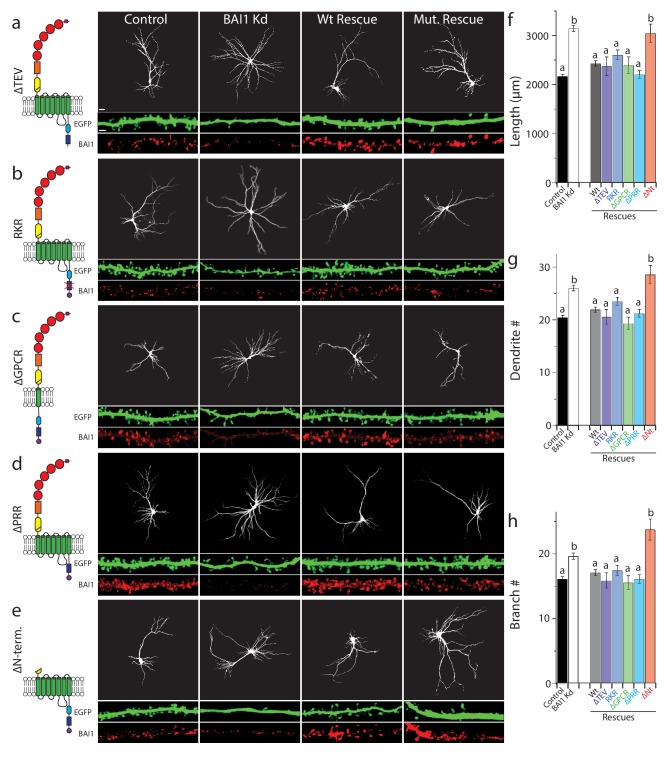
BAI1 requires its extracellular segment to inhibit dendrite growth, but does not employ any known intracellular signaling modality to do so.a through e Representative images of neurons expressing EGFP and control vector (Control), shRNA against Adgrb1 (BAI1 Kd), or shRNAs against BAI1 plus RNAi-resistant BAI1 (Wt rescue) or an RNAi-resistant BAI1 mutant (Mut. rescue). All images are masked to remove axons and dendrites from other neurons. The mutant used for rescue in each series is shown in cartoon form on the left. Mutants used included a deletion of the PDZ-binding core sequence (a), an RKR→AAA mutation in the helical domain that prevents ELMO1 binding (b), deletion of all but the first transmembrane domain of the GPCR domain (c), deletion of the proline-rich region (d), and deletion of the entire N-terminal extracellular segment between the signal sequence and the native autoproteolysis site (e). Representative EGFP images of the entire arbor are on top (bar is 20 µm), while EGFP and BAI1 immunochemistry images reconstructed from 3D confocal stacks of secondary dendrites taken from the same experiments are shown immediately under these (bar is 2.5 µm). (f) Summary data for dendrite length. (g) Summary data for dendrite number. (h) Summary data for branch number. Total number of neurons: 314 for control neurons (N = 24), 288 for BAI1 Kd neurons (N = 24), 235 for wt rescue neurons (N = 24), 29 for ∆TEV rescue neurons (N = 3), 86 for RKR rescue neurons (N = 9), 39 for ∆GPCR neurons (N = 3), 72 for ∆PRR neurons (N = 3), and 37 for (N = 3) for ∆Nterm. rescues. Data are represented ± s.e.m. (aP >0.05 within group a, but p<0.05 vs. group b; bP >0.05 within group b, but p<0.05 vs. group a.) Detailed statistics are found in Figure 5—source data 1.10.7554/eLife.47566.044Figure 5—source data 1.Statistical summary for Figure 5: ANOVA and key Tukey post-hoc tests and N and n values for Figure 5f–h.10.7554/eLife.47566.042Figure 5—source data 2.Individual measurements of dendritic parameters in control neurons and those with molecular replacements with BAI1 mutants (Figure 5).10.7554/eLife.47566.043Figure 5—source data 3.Individual measurements of primary dendrites in molecular replacement experiments and dendrite arbor lengths when neuronal activity is modulated (Figure 5—figure supplement 1b,i).